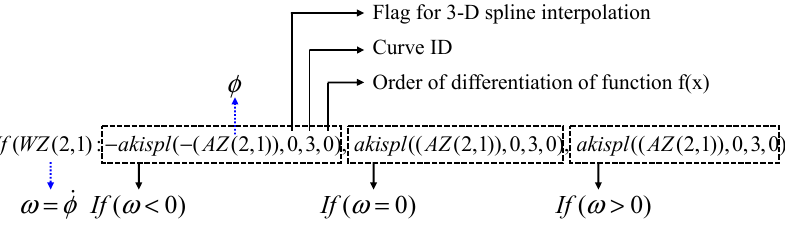
Figure 5. Expression function for the implementation of the path-dependent stiffness of TS hinges in RecurDyn.